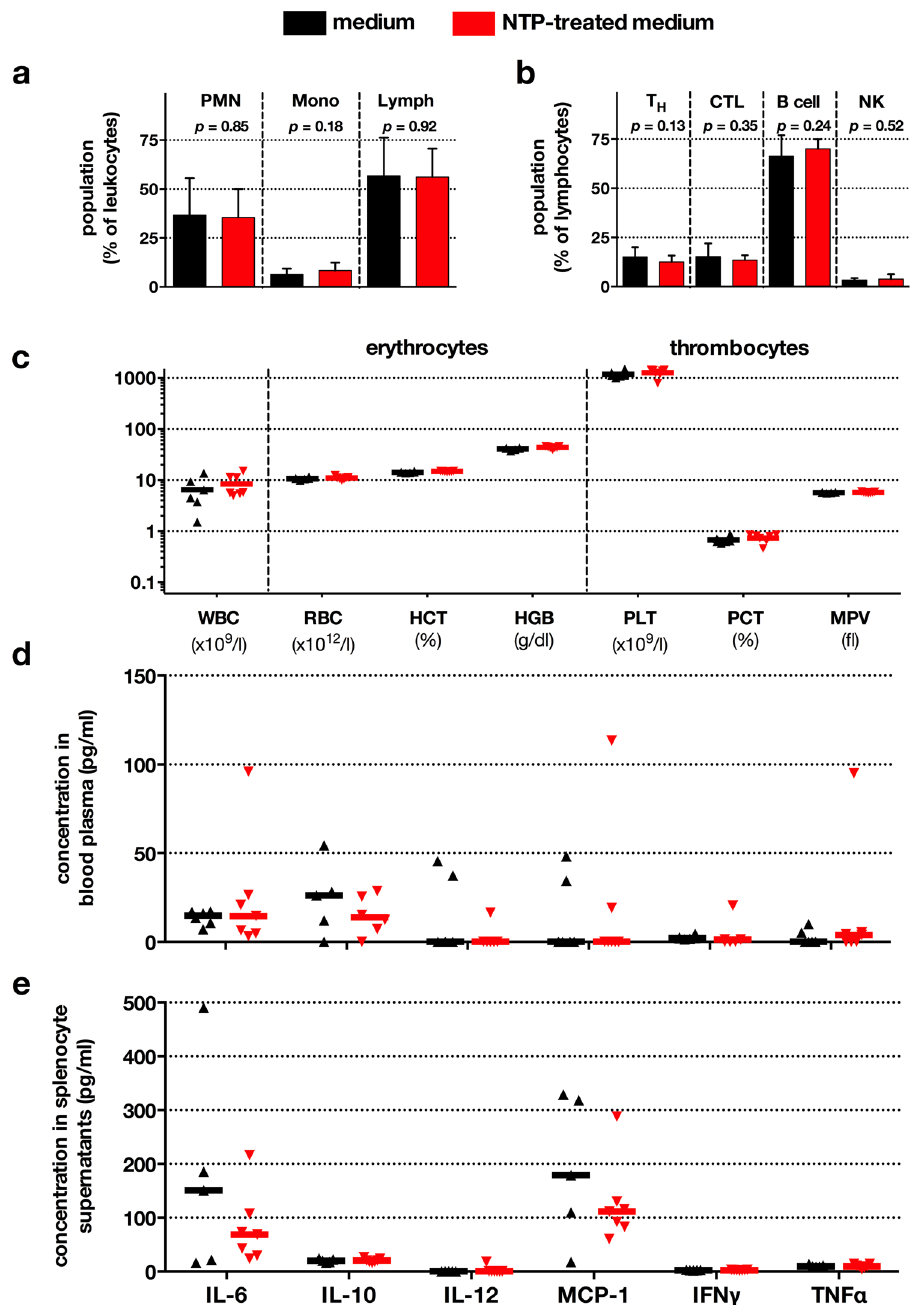
Figure 7. Blood parameters, leukocyte distribution, and cytokine signatures remained largely unaffected. Tumor-bearing mice were sacrificed after receiving untreated or NTP-treated medium for 21